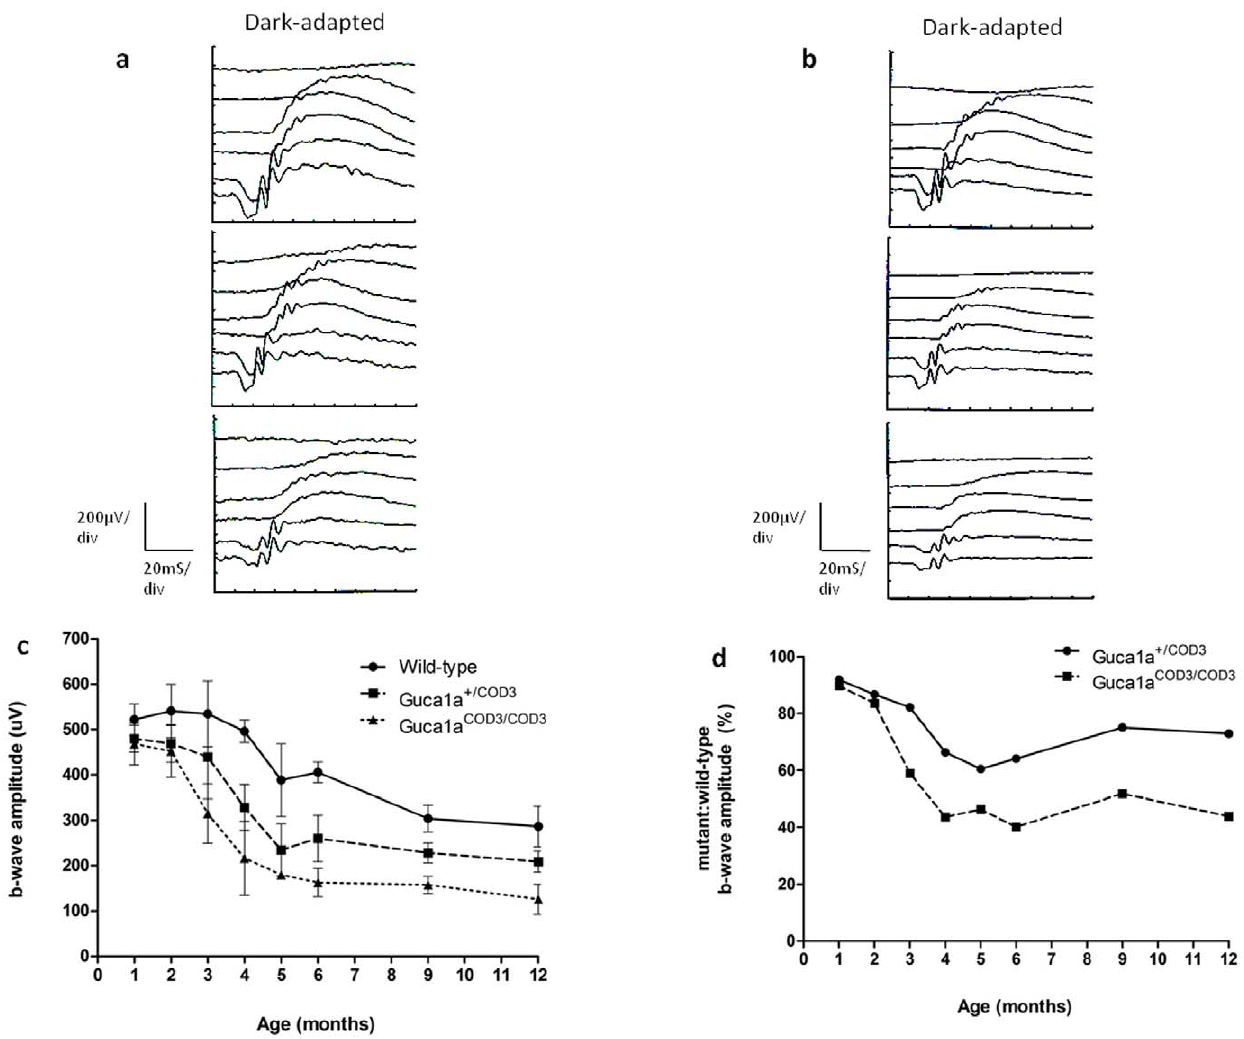
Figure 4. Reduced rod function in Guca1a COD3 ‘knock-in’ mice. ( a ) Representative ERG traces taken from dark-adapted 5 month-old wild-type, Guca1a + /COD3 and Guca1a COD3/COD3 mice, showing a reduction in a- and b-wave amplitude in mutant mice in the rod-dominated ERG in response to a series of increasing stimulus intensities. ( b ) Representative ERG traces taken from dark-adapted 12 month-old wild-type, Guca1a + /COD3 and Guca1a COD3/COD3 mice, showing that rod function is relatively spared when compared with cone function. ( c ) Averaged scotopic, rod-dominated b- wave amplitudes from wild-type, Guca1a + /COD3 and Guca1a COD3/COD3 mice recorded over a twelve month period from birth. Mean values were calculated from b-wave amplitudes from 100 mcds/m 2 flash intensity, which corresponds to a rod-only response. Note the age-related decline in wild-type mice. ( d ) Rod b-wave amplitudes in Guca1a + /COD3 and Guca1a COD3/COD3 mice plotted as a percentage of wild-type amplitudes over a twelve month period from birth.